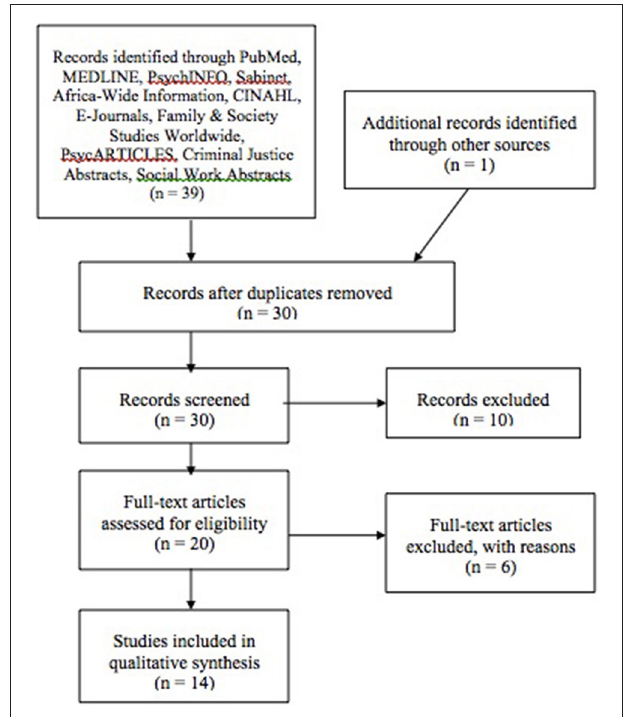
FIGURE 1 | Flow diagram of review inclusions and exclusions. Source:Moher et al.